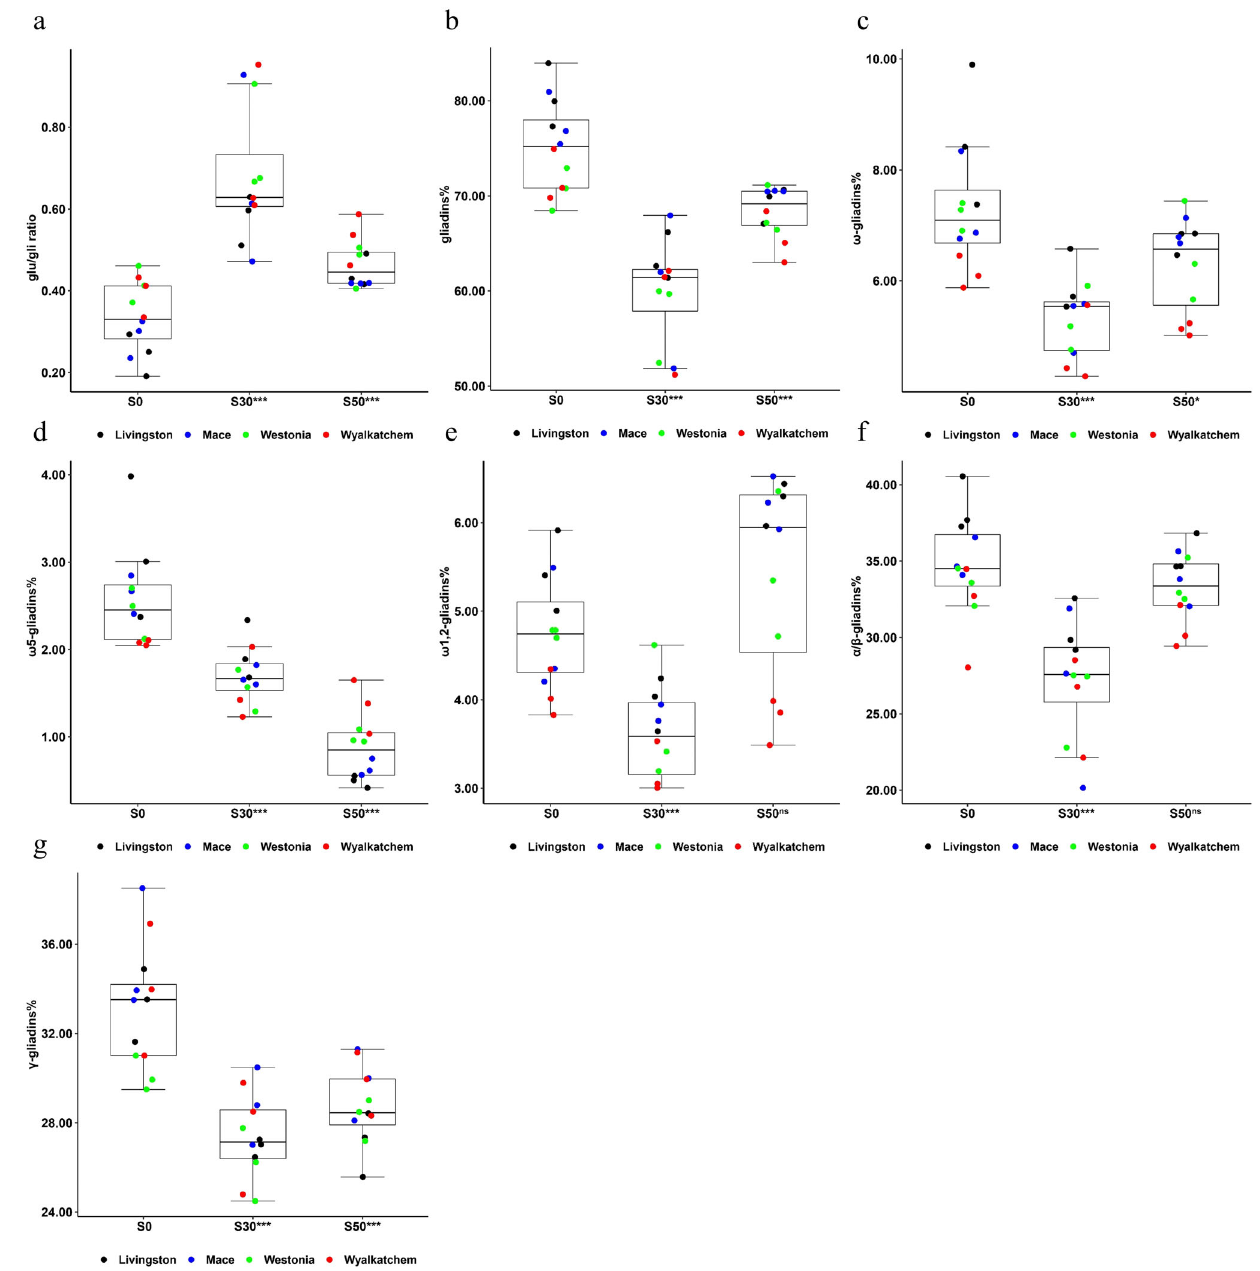
Fig. 3 Effects of sulfur treatments on the ratio of glutenin to gliadin, the percentages of gliadins and its each subtype in the total gluten content in 2014 fi eld trial. For all panels, S0, S30, S50 mean 0, 30 and 50 kg ha − 1 sulfur treatments, respectively; * P < 0.05; ** P < 0.01; *** P < 0.001; ns not signi fi cant; the number of biologically independent replicate (or plot) for each cultivar under each sulfur treatment is 3. Boxplot shows the median and interquartile ranges (IQR); the end of the top line is the third quartile (Q3) + 1.5 × IQR; the end of the bottom line is the fi rst quartile (Q1) − 1.5 × IQR. The dots with black, blue, green and red show the data distribution of the four cultivars Livingston, Mace, Westonia and Wyalkatchem under each sulfur treatment. The effects of sulfur treatments on the ratio of glutenin to gliadin, the percentages of gliadins and its each subtype in the total gluten content of each cultivar were shown in Supplementary Fig. 9. a The changes in glu/gli ratio of the four cultivars caused by S30 and S50 treatments. b The changes in the percentage of gliadins in the total gluten content (gliadins%) of the four cultivars caused by S30 and S50 treatments. c The changes in the percentage of ω - gliadins in the total gluten content ( ω -gliadins%) of the four cultivars caused by S30 and S50 treatments. d The changes in the percentage of ω 5-gliadins in the total gluten content ( ω 5-gliadins%) of the four cultivars caused by S30 and S50 treatments. e The changes in the percentage of ω 1,2-gliadins in the total gluten content ( ω 1,2-gliadins%) of the four cultivars caused by S30 and S50 treatments. f The changes in the percentage of α / β -gliadins in the total gluten content ( α / β -gliadins%) of the four cultivars caused by S30 and S50 treatments. g The changes in the percentage of γ -gliadins in the total gluten content ( γ -gliadins%) of the four cultivars caused by S30 and S50